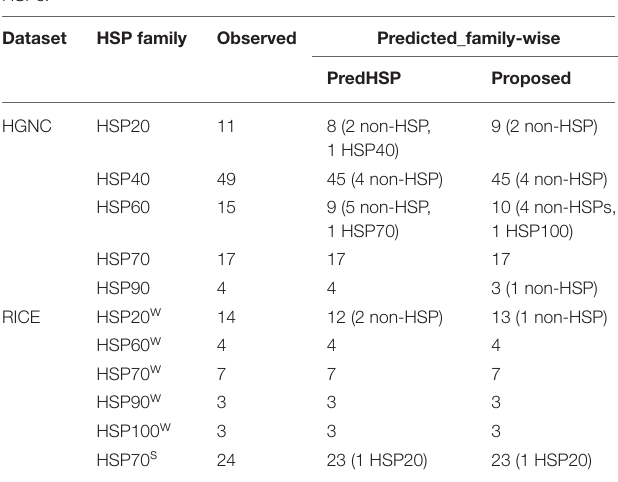
TABLE 6 | Number of observed and correctly predicted HSPs by the proposed approach and PredHSP for the independent dataset of 96 human and 55 rice HSPs.